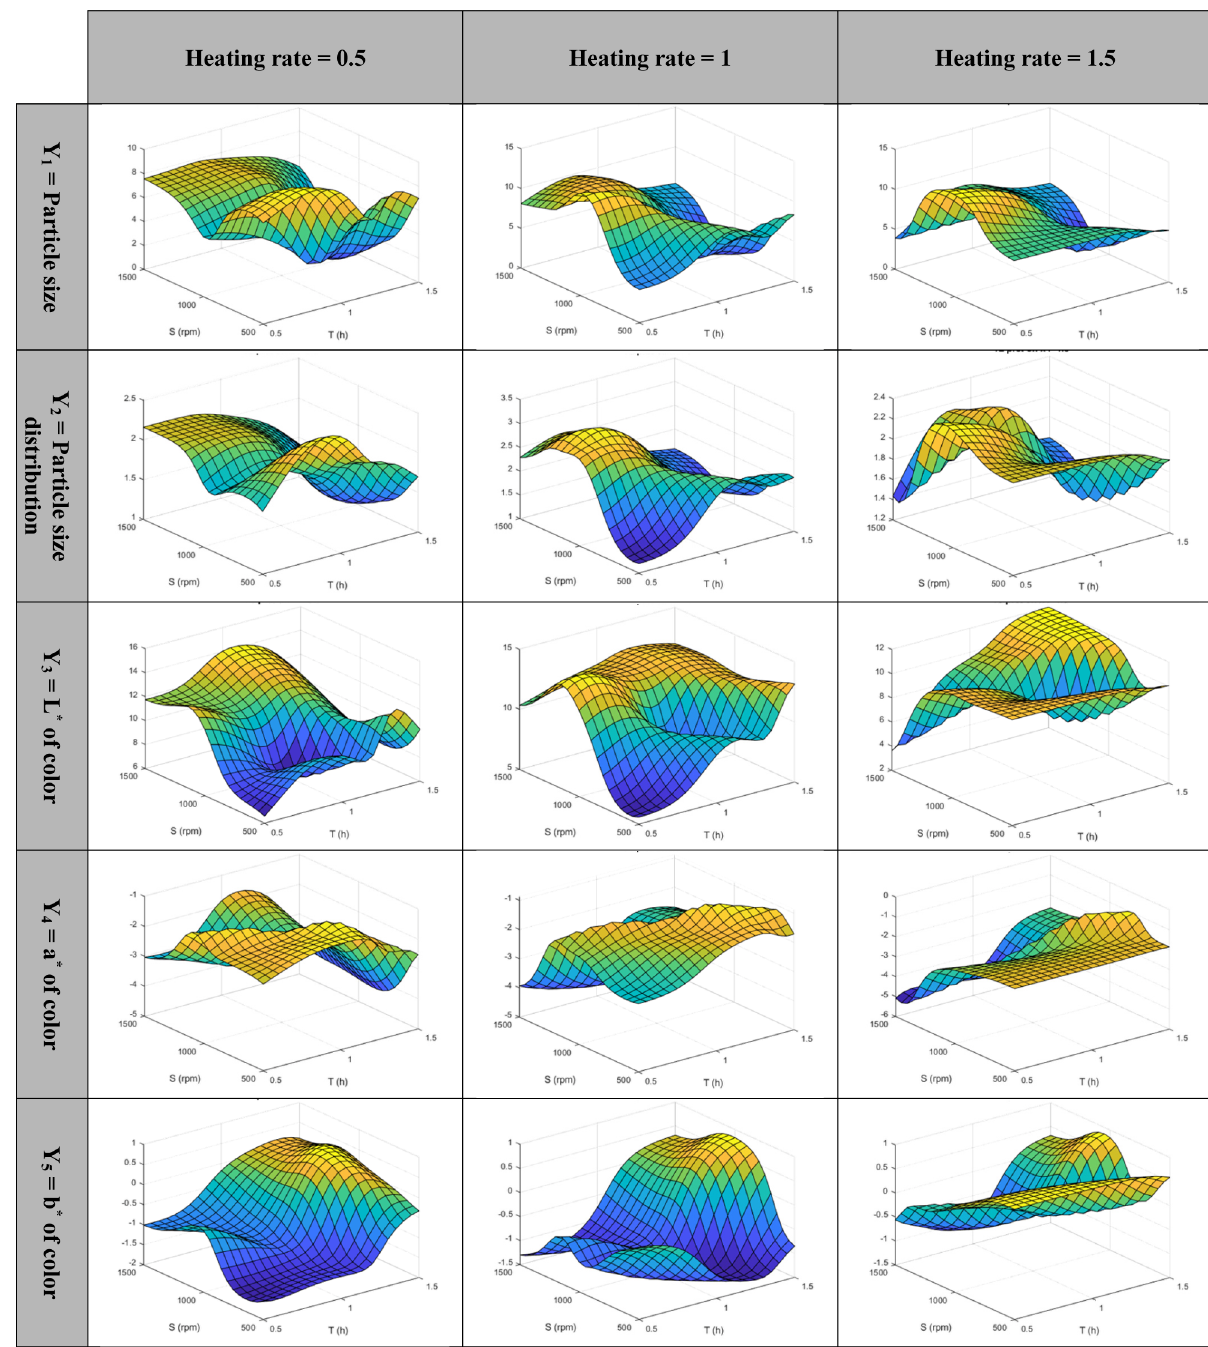
Figure 7: 3D plots of modelling responses (PS, and PSD, and color (L*, a*, b*)) in constant values of heating